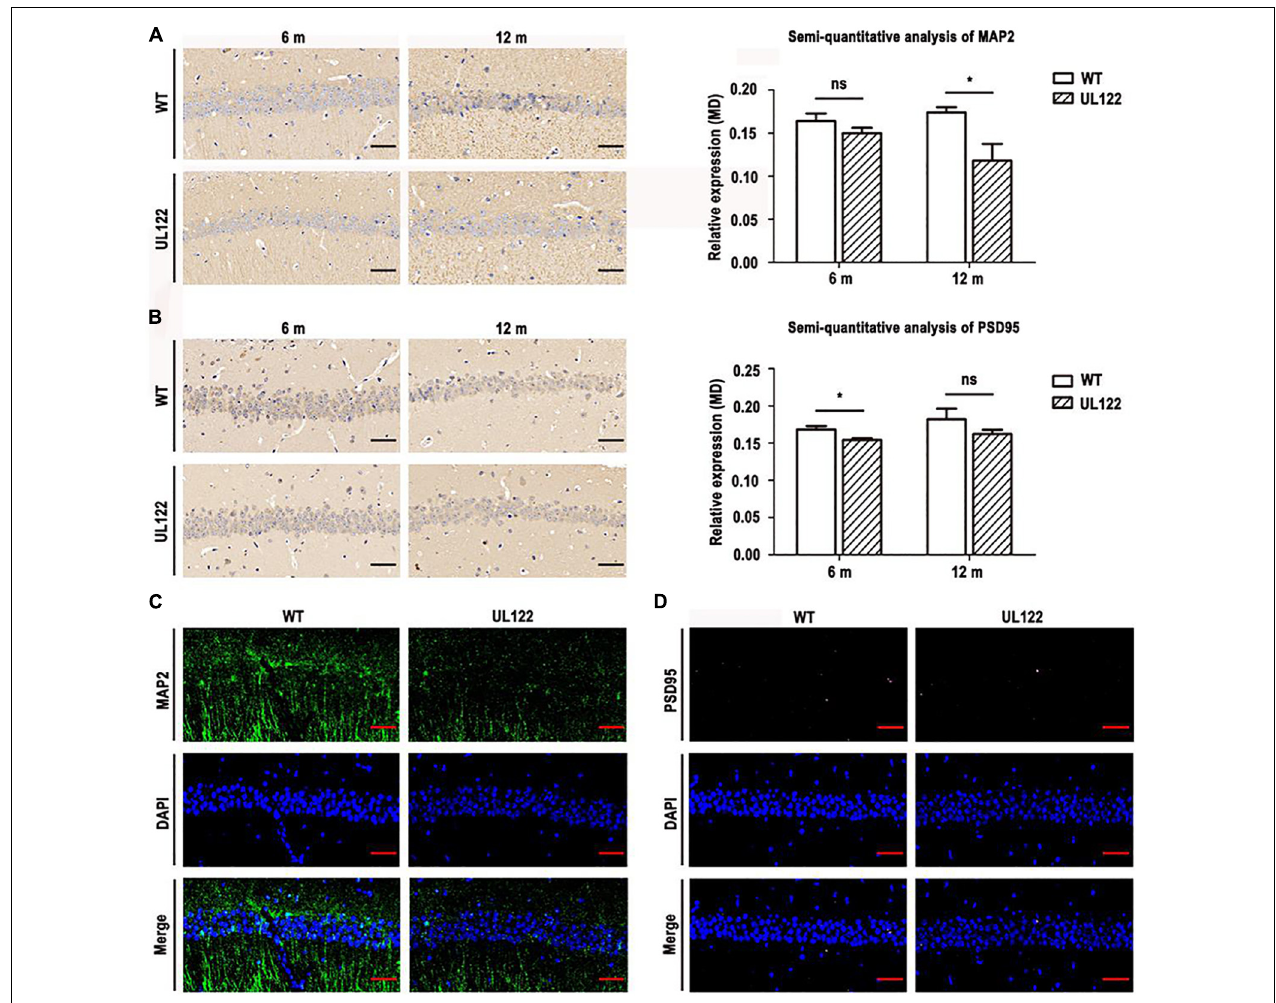
FIGURE 6 | The expression of MAP2 and PSD95 in the hippocampal CA1 region of mice aged 6 and 12 months. (A) MAP2 immunohistochemistry and semi-quantitative analysis of immunohistochemistry for MAP2. (B) PSD95 immunohistochemistry and semi-quantitative analysis of immunohistochemistry for PSD95. (C) The expression of MAP2 and PSD95 in the CA1 region of mice aged 12 months measured by immunofluorescence. (D) The expression of PSD95 in the CA1 region of mice aged 12 months measured by immunofluorescence. MAP2 detected with a primary monoclonal antibody (green), PSD95 detected with a primary monoclonal antibody (pink), nuclei stained with DAPI (blue), merged mage. The bars indicate the means ± SEM( n = 4 for each group). Statistical analysis was performed by unpaired t -test. * P < 0.05: significantly different from the WT